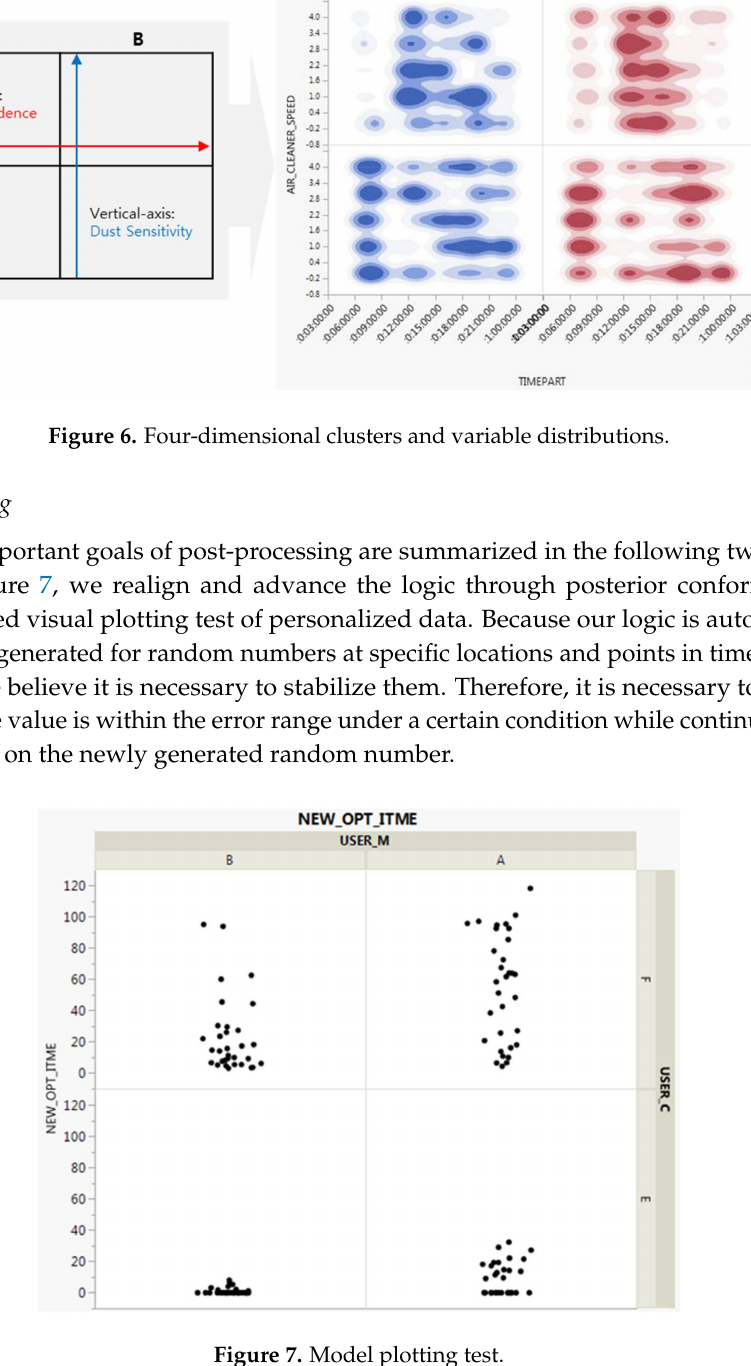
Figure 7. Model plotting